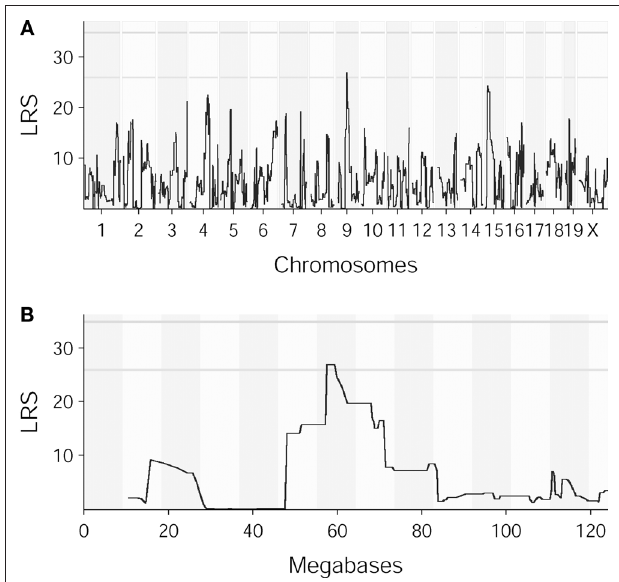
Figure 5 | QTL maps for lever press–nose poke performance (A) QTL map for lever press–nose poke performance in the fifth session of training. LRS reaches suggestive threshold on chromosome 9. (B) QTL map for lever press–nose poke performance in the fifth session of training, zoomed in on chromosome 9. LRS peak is situated around 58 MB. The abscissa runs from 0 to 124